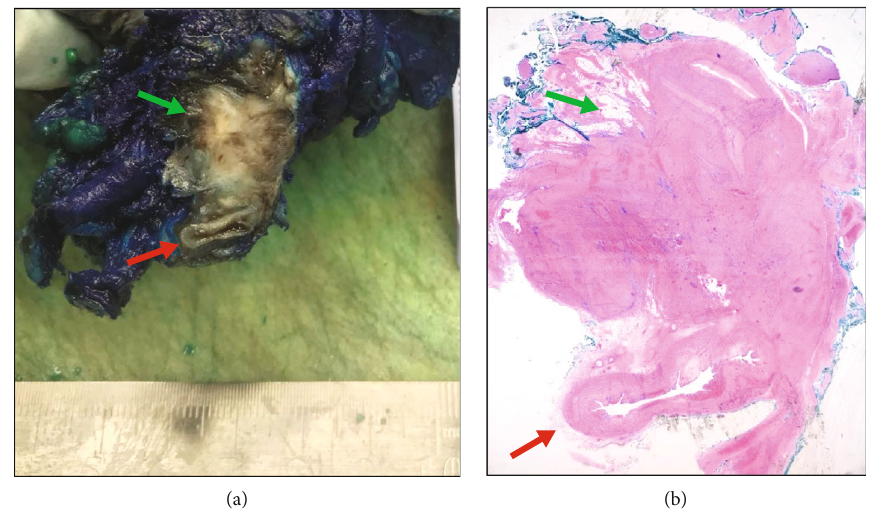
Figure 2: (a) Macroscopic and (b) microscopic correlation of a poorly circumscribed lesion, with a white and whorled appearance, on the cut surface, that in fi ltrates the surrounding soft tissue (indicated by the green arrows). The tumor compresses the adjacent ureter (indicated by the red